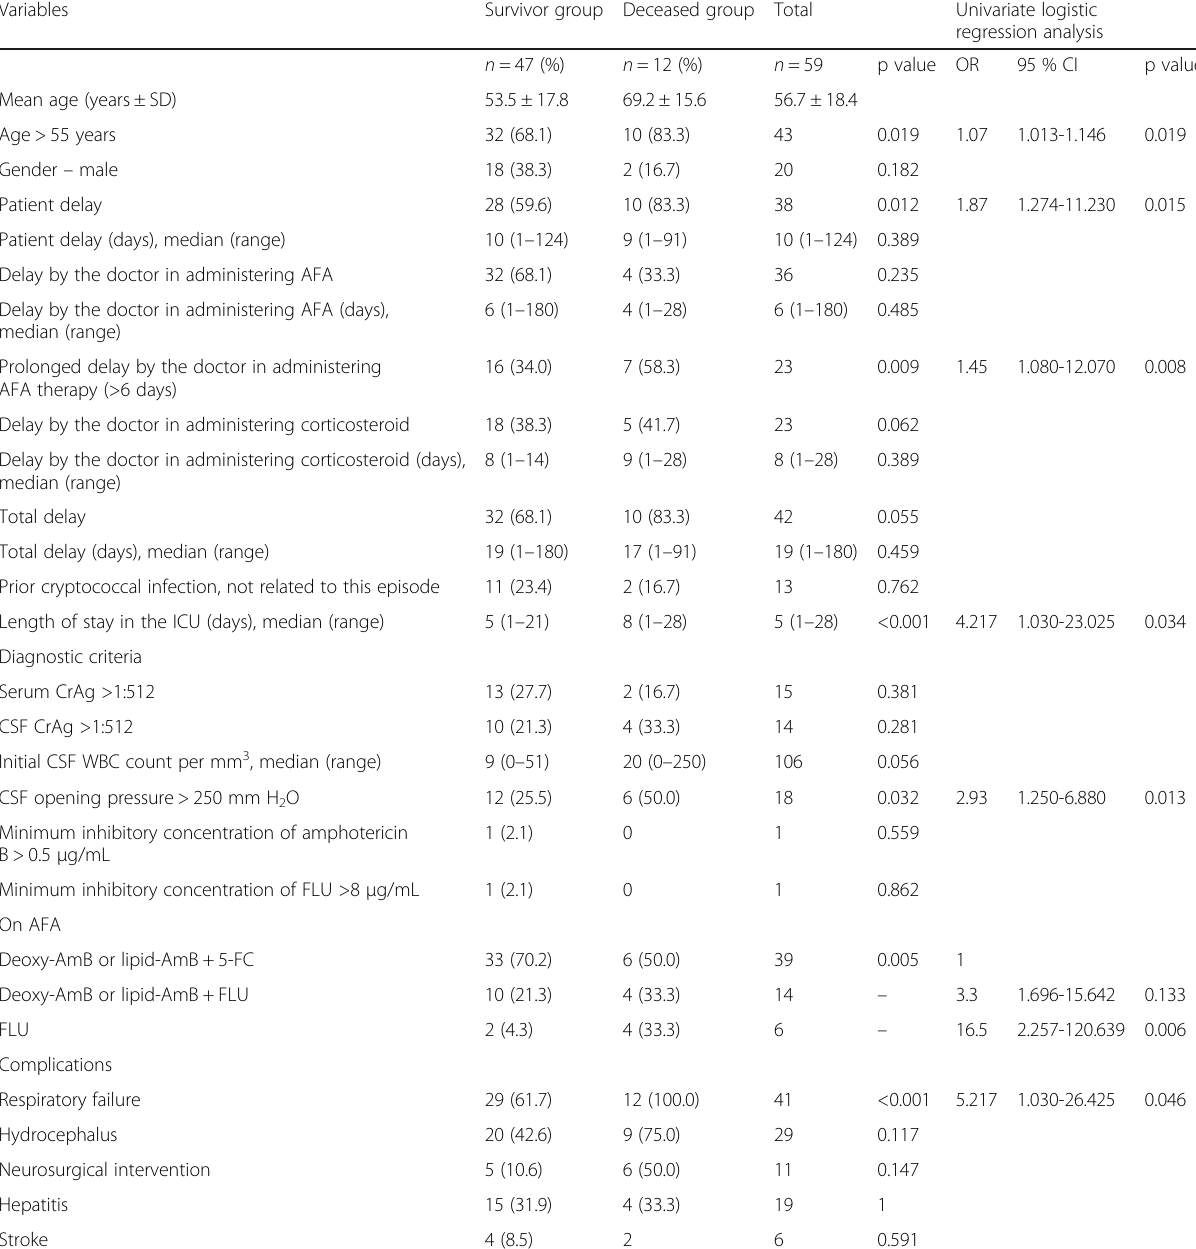
Table 2 Comparison of induction regimens with combination therapy between survival and deceased groups of CM patients Variables Survivor group Deceased group Total Univariate logistic